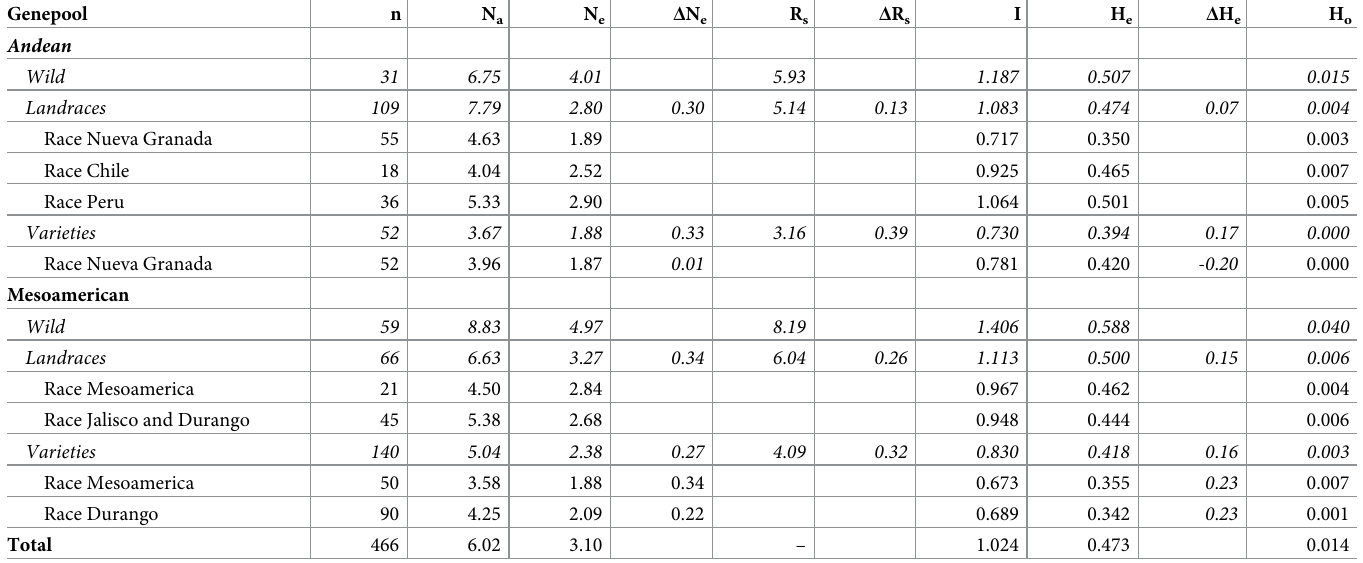
Table 4. Diversity and relative diversity loss between landraces and commercial advanced cultivars of Andean and Mesoamerican common bean races.